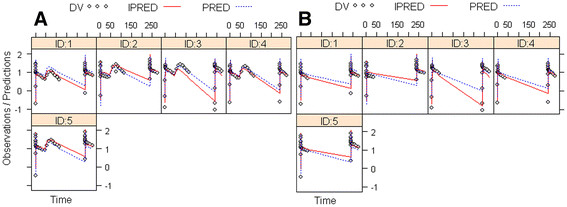
Modeling results of (R)-[11C]verapamil concentration-time curves in WB gray matter in ln(Bq/ml) over time (min). (A) WB gray matter was compared with (B) WB* gray matter excluding the increase of (R)-[11C]verapamil brain uptake after treatment with tariquidar. Tariquidar (2 mg/kg) was administered at 40 min after start of tracer injection as an intravenous infusion over 30 min and post-inhibition scan was started 2 h 50 min after end of tariquidar infusion. Each panel represents one volunteer, open gray circles represent measurements (DV), solid red lines represent the model predictions for each individual subject (IPRE), and broken blue lines represent the population model predictions (PRED).